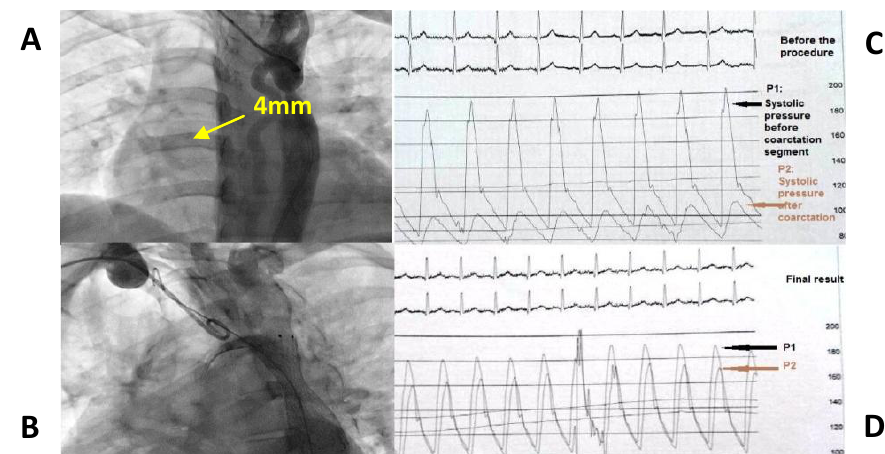
Figure 3. A) The narrowest segment of coarctation was about 4 mm in the aortography. B) Final result of implantation of a self-expanding stent and post-dilation of the stent by using of an 8 mm-diameter balloon-in-balloon (BIB) balloon. C) Before the procedure, the systolic pressure gradient across the aortic coarctation was about 200 mmHg and D) after the procedure it decreased to 15-20